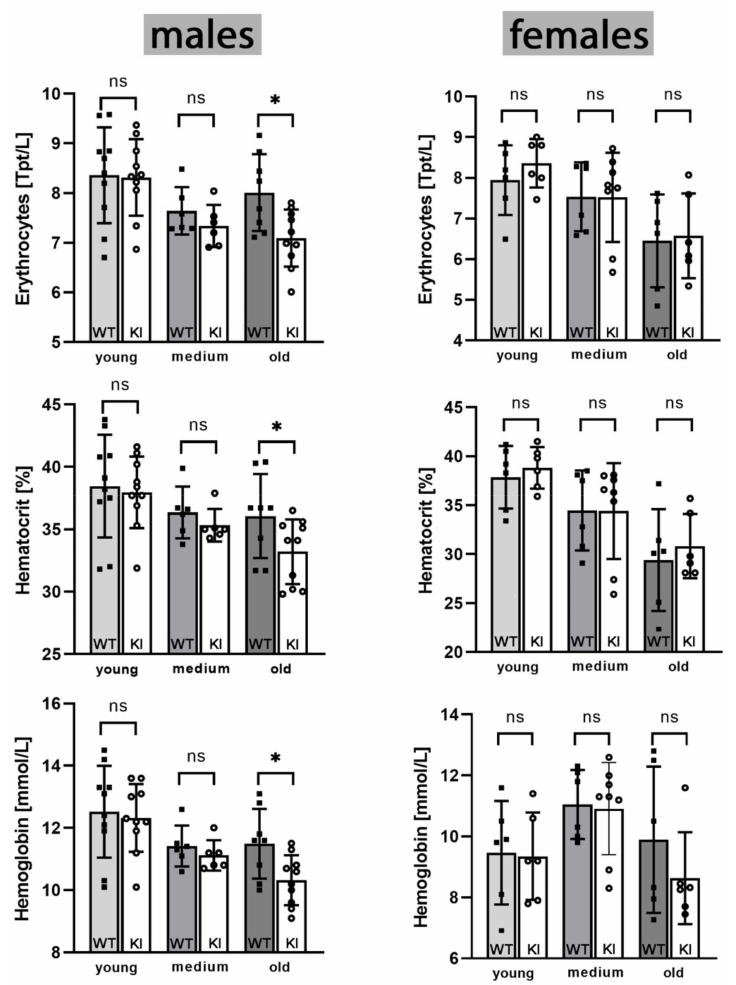
Figure 7. Comparison of basic erythrocyte parameters of Alox15b -KI mice and outbred wildtype controls of either sex. Alox15b -KI mice and outbred wildtype controls of either sex were classified in three age categories (young mice, 10–20 weeks; middle-aged mice, 30–40 weeks; old mice 70–80 weeks, n ≥ 5 for each age group). After sacrificing the animals by cervical dislocation under anesthesia, EDTA blood was removed by heart puncture. The basic hematological parameters were determined by the Institut für Veterinärmedizinische Diagnostik GmbH (Berlin, Germany). Relevant erythrocyte parameters are shown in this image. The complete sets of hematological parameters are given in Figures S1 and S2. * indicates significant differences ( p < 0.05). ns, no significant difference.